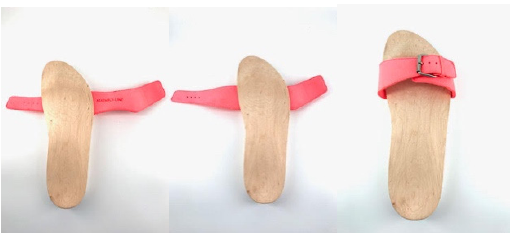
Figure 3. Original sandal design: Assembly-Line 01 ©, by Marijke Bruggink.